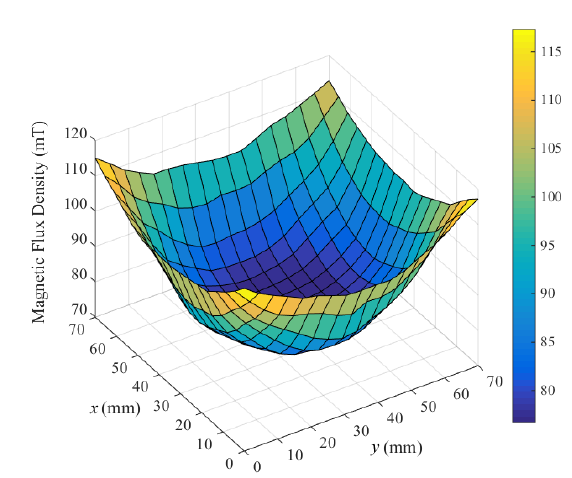
Figure 7. The distributed magnetic flux density on the cross-section of the transformer core when l g = 0